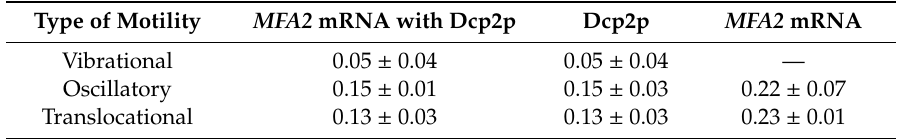
Table 3. Velocities of MFA2 granules with and without PB protein.